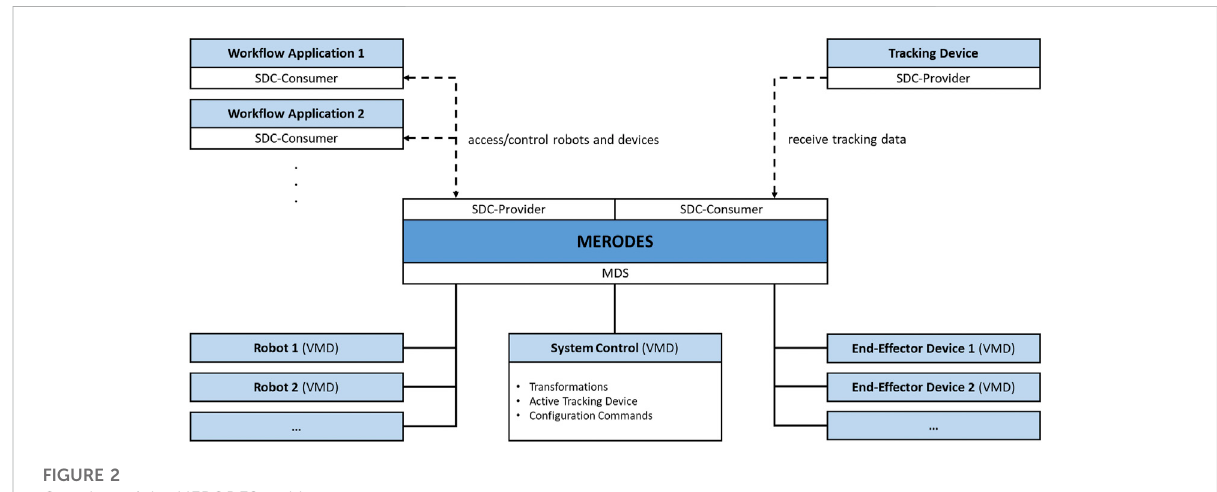
FIGURE 2 Overview of the MERODES